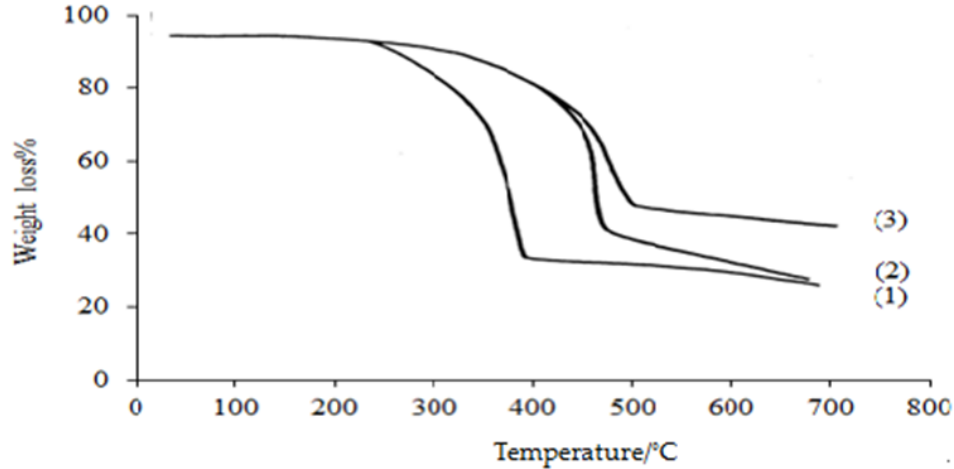
Figure 8. Thermal gravimetric analysis for the polypropylene samples. 1—PP blank, 2—PP-grafted, 3—PP amidoximated.